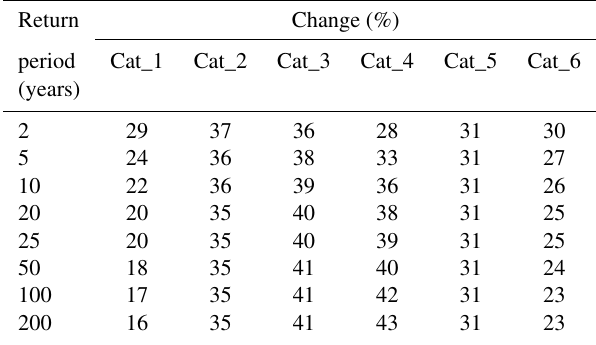
Table 8. Changes in the number of 3h floods which are greater than the minimum annual maximum flood in the reference period for all the study catchments.